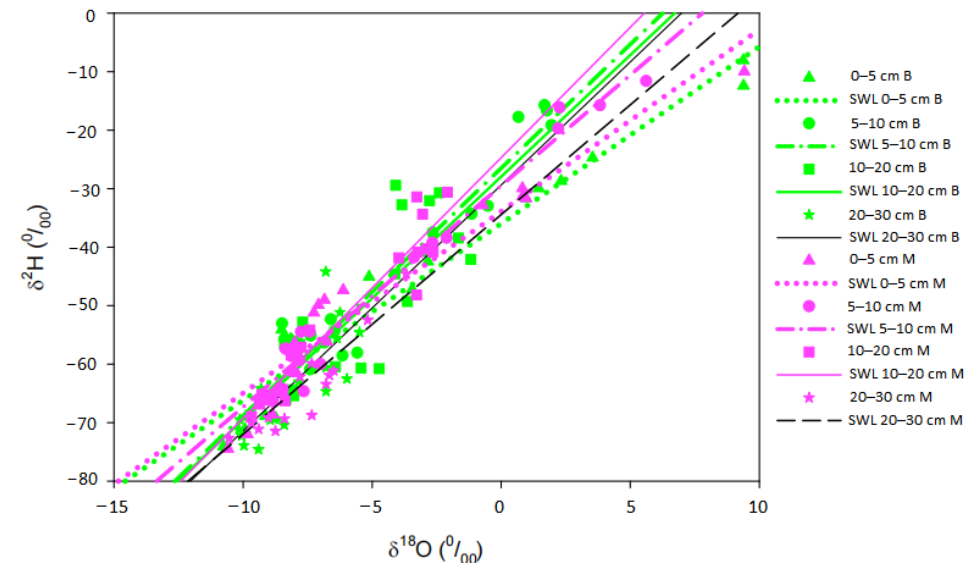
Figure A2. δ 2 H- δ 18 O relationship in soil water at different depth. Bromus inermis grassland (B) and Medicago sativa grassland (M).